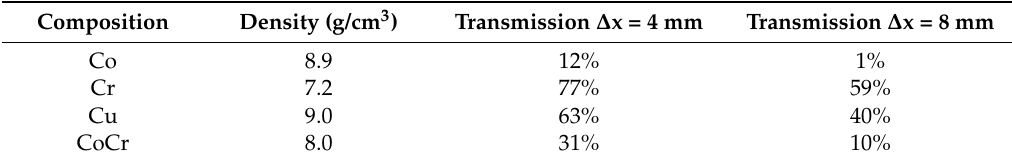
Table 2. Table of neutron transmission through the elements, and the CoCr-rich phase, used in this